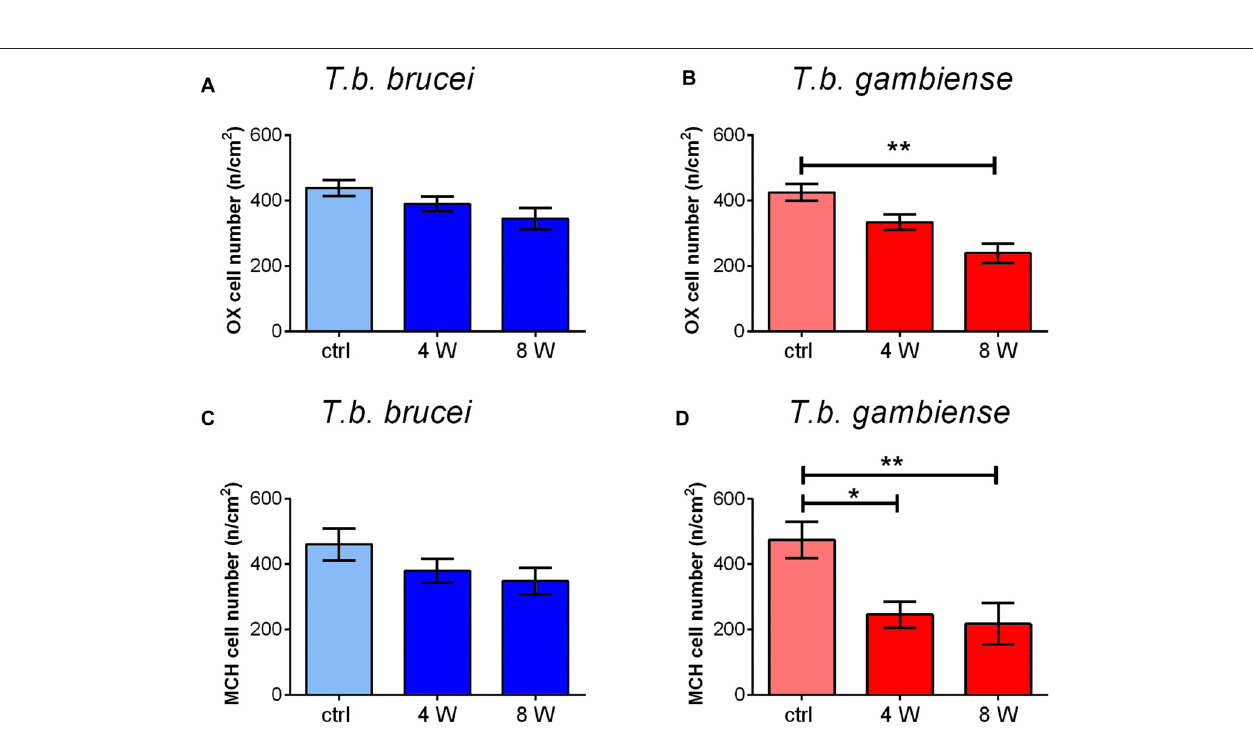
FIGURE 5 | The bar graphs illustrate the stereological counts of neurons containing OX-A (A,B) or MCH (C,D) in control (ctrl) Mastomys natalensis and at 4 weeks (W) and 8 W after infection with Trypanosoma brucei ( T. b. ) brucei (A,C) or T. b. gambiense (B,D) . ∗ P < 0.05; ∗∗ P < 0.001.